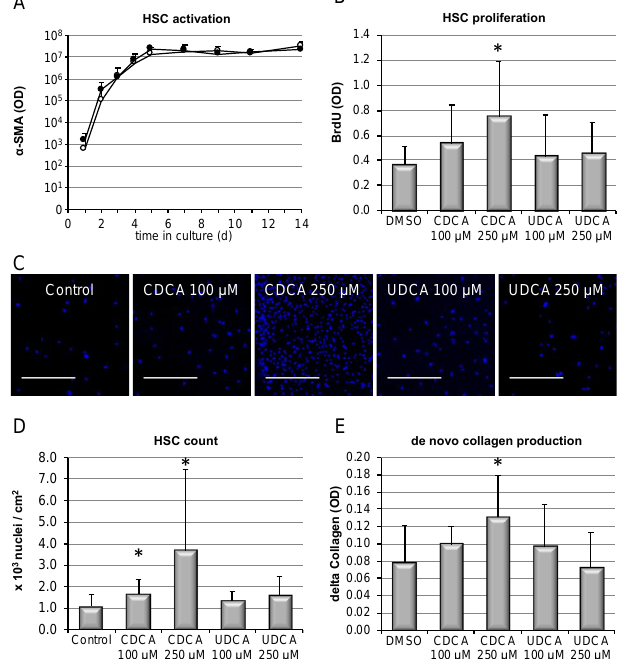
Figure 4. Hydrophobic bile salts promote HSC proliferation and accumulation and collagen deposition. HSCs were isolated from wild-type mice as described above. ( A ) α SMA expression was determined by western blotting during long-term stimulation with CDCA 100 μM (closed circles) or DMSO only (control, open circles) to determine the slope of HSC activation (n = 5, each). For subsequent experiments, cells were stimulated with CDCA or UDCA at the indicated concentrations. DNA incorporation was determined after 7 days of culture ( B ). Following a total culture period of 14 days, the absolute number of HSC was determined; cells were seeded in chamber slides, stimulated with the indicated bile salts, stained with DAPI, and pictures were obtained with a slide scanner. Sections of representative pictures are shown in ( C ), where the scale bar represents 500 μm. Resulting cell count was quantified with ImageJ2 software ( D ). To test the functional consequence of excess cell accumulation, de novo collagen production from 7 to 14 days of culture was determined ( E ). Results are shown as mean ± standard deviation (n = 8 for B–D, * p < 0.05, ANOVA, post-hoc LSD). 3.5. Bile-Salt-Induced HSC Proliferation is Associated with Activation of the MEK/Erk Signaling Cascade In order to identify the signaling pathways involved in bile salt-induced proliferation of HSC, western blotting was performed on cell lysates of cultured HSCs. Following stimulation with CDCA for up to 10 days, dose-dependent Erk phosphorylation was detected, which was preserved in long-